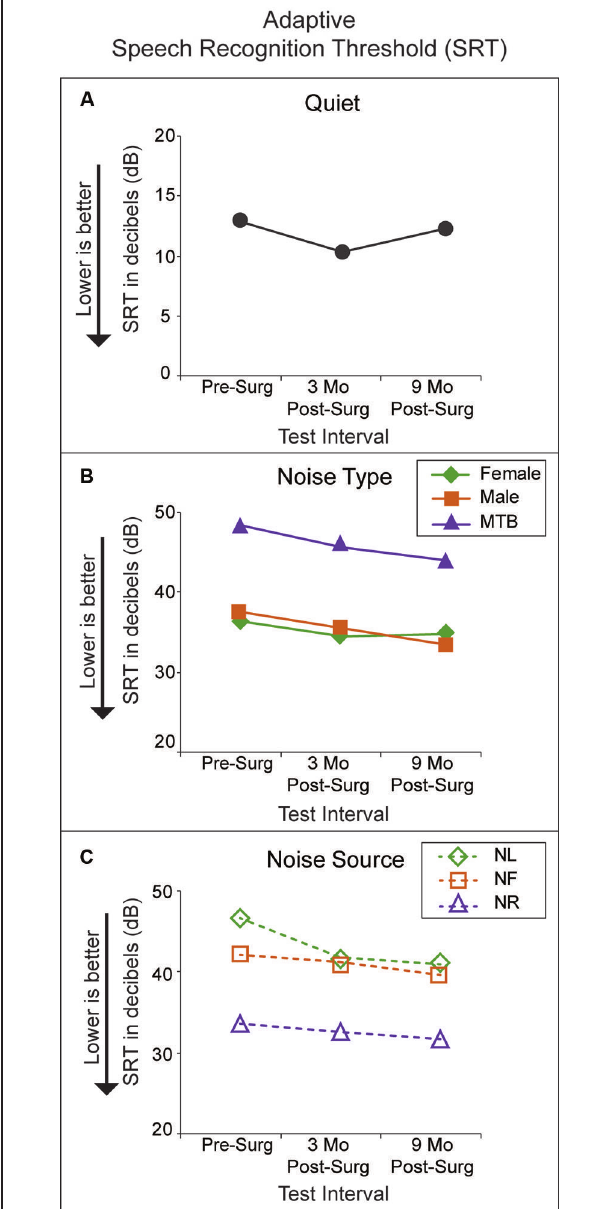
FIGURE 4 | Adaptive SRT scores in dB ( y -axis) are plotted for each test interval ( x -axis) . Lower SRTs reflect ability to hear speech at softer levels. Panel A plots results in quiet (black circles). Panel B plots results in noise by noise type (female talker with green diamonds; male talker with orange squares; MTB with purple triangles). Panel C plots results in noise by noise source location (noise from the left, or NH ear side with green diamonds; noise from the front with orange squares; noise from the right, or hearing impaired ear side with purple diamonds).